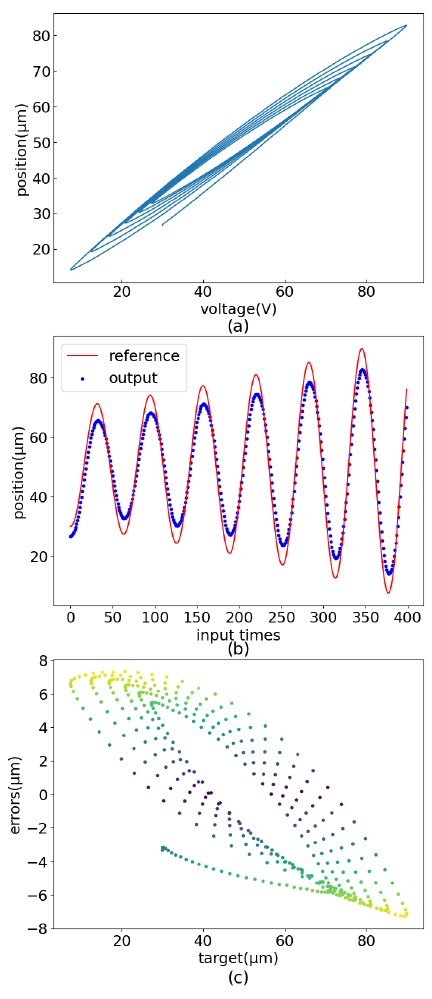
Figure 6. Secondary hysteresis loop linear analysis result graph (amplified sinusoidal input signal). ( a ) Amplified sinusoidal output. ( b ) Amplified sinusoidal curve comparision. ( c ) Amplified sinusoidal error